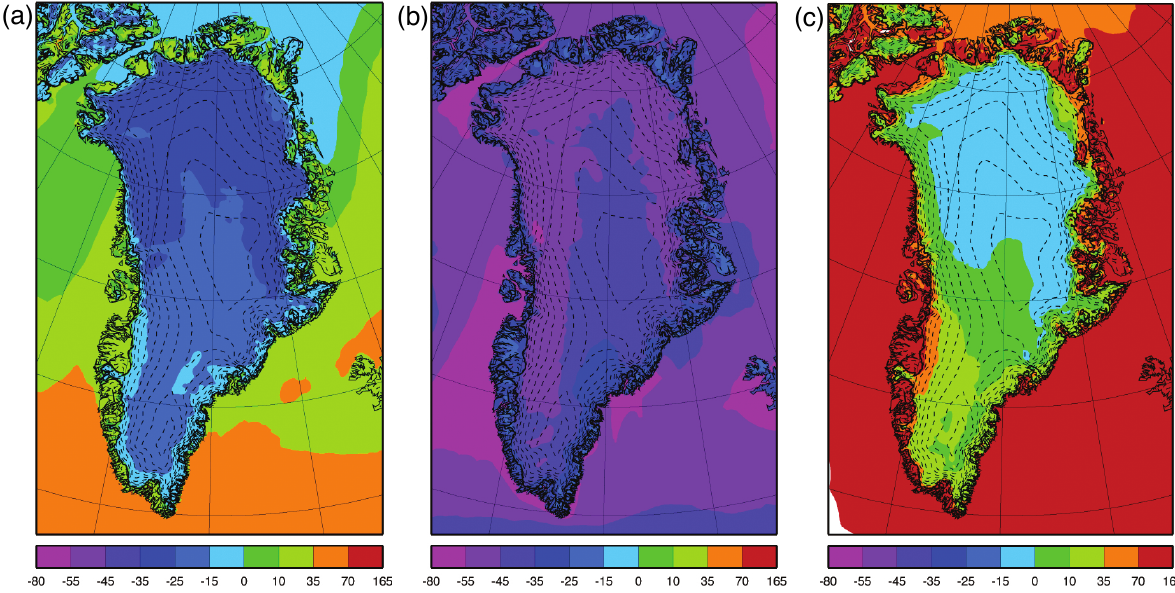
Fig. 11. Averaged net surface radiation [Wm − 2 ]) over (a) a year, and the seasons (b) DJF and (c) JJA.